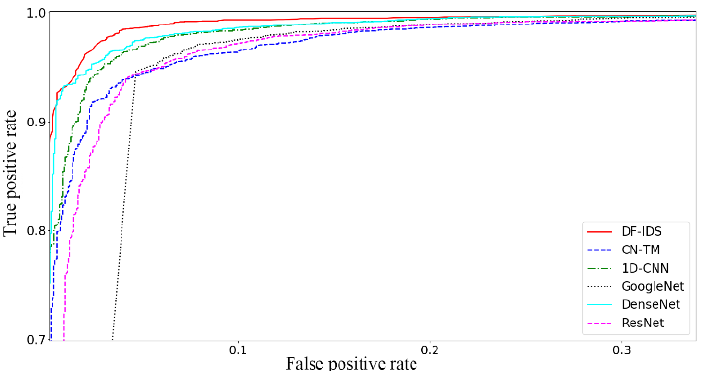
Figure 11. ROC curves of binary-classification model with smaller-scale dataset. Table 13. Performance of multiclassification model with smaller-scale dataset.